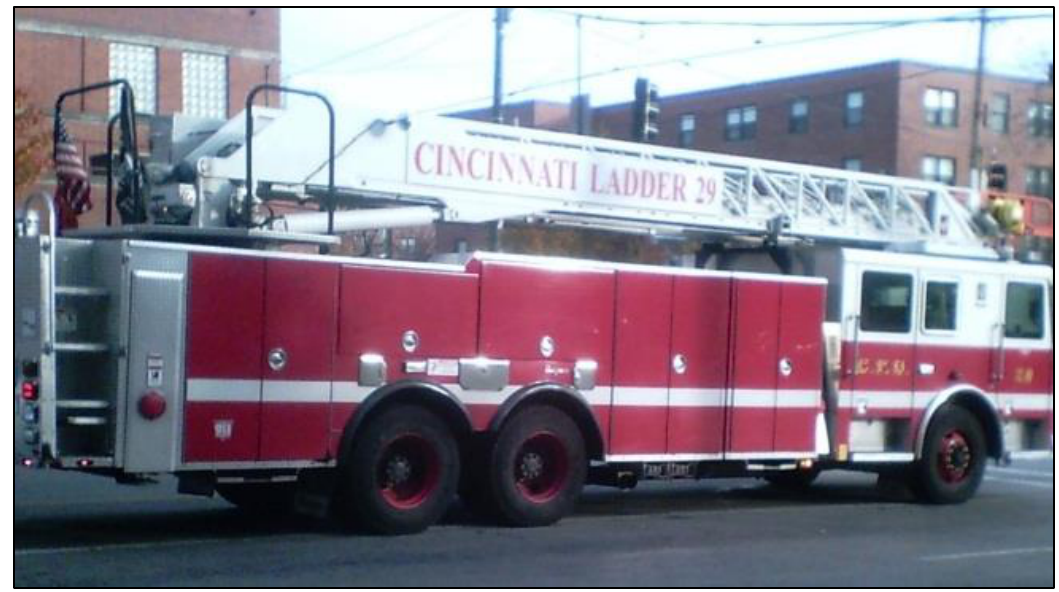
Figure 4. Photo caption: helpers; Health topic: body; “My photo is of a fire